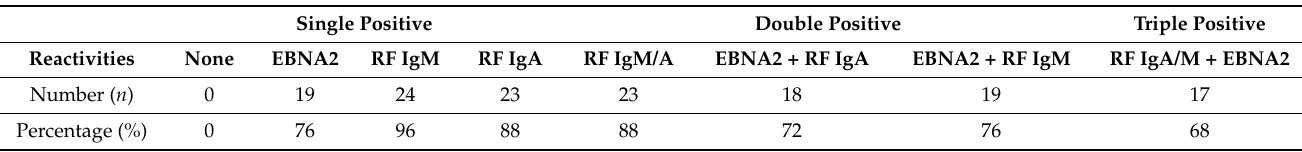
Table 2. Serologic reactivities to EBNA2-A, RF IgM and RF IgA.